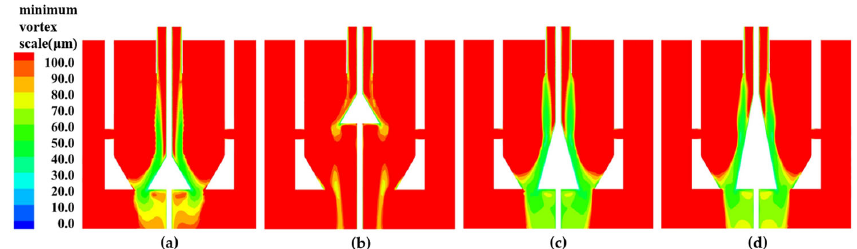
Figure 12. Distribution of the minimum vortex scale in the flow field of the feedwell: ( a ) α a = 60°; ( b ) α b = 60°, with the bottom height of the conical deflector of ( b ) being 1766 mm higher than that of ( a ); ( c ) α c = 30°; and ( d ) α d = 21.1°.